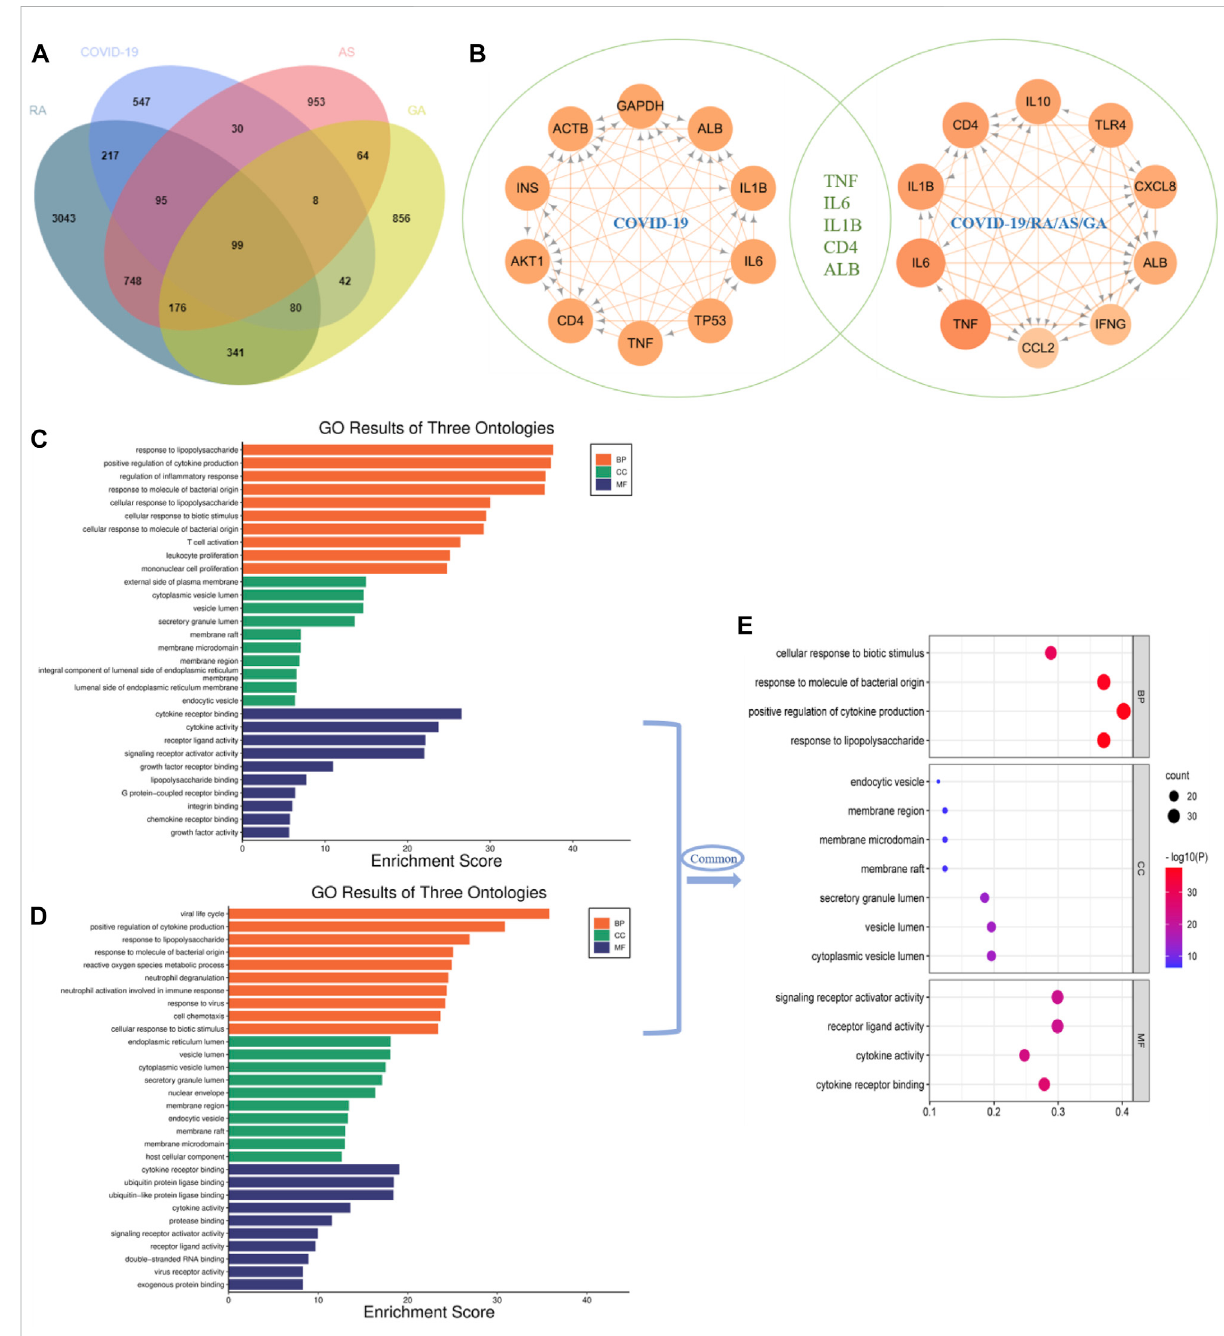
FIGURE 2 The common hub targets and GO process of single disease (COVID-19) and multiple disease combinations (COVID-19, RA, AS, GA). (A) Multi- disease combination (COVID-19, RA, AS, GA) 99 common targets. (B) Single disease (COVID-19) targets ranked TOP10 targets (left), multi-disease combination(COVID-19,RA,AS,GA) common targetsranked TOP10targets (right), theintersectionofthetwo, fi vecommontargetswereobtained: TNF, IL-6, IL-1 β , CD4 and ALB, these fi ve targets not only play a central role in the pathogenesis and progression of single disease (COVID-19), butalsoarepotentialtargetsforthetreatmentofRA,ASandGA. (C) ThecommonGOprocessinvolvedinmultiplediseasecombinations(COVID-19, RA, AS, GA). (D) The GO process involved in single disease (COVID-19). (E) The common GO process obtained by the intersection analysis of single disease (COVID-19) and multiple disease combinations (COVID-19, RA, AS, GA), and mainly involves response to lipopolysaccharide, positive regulation of cytokine production, cytokine receptor